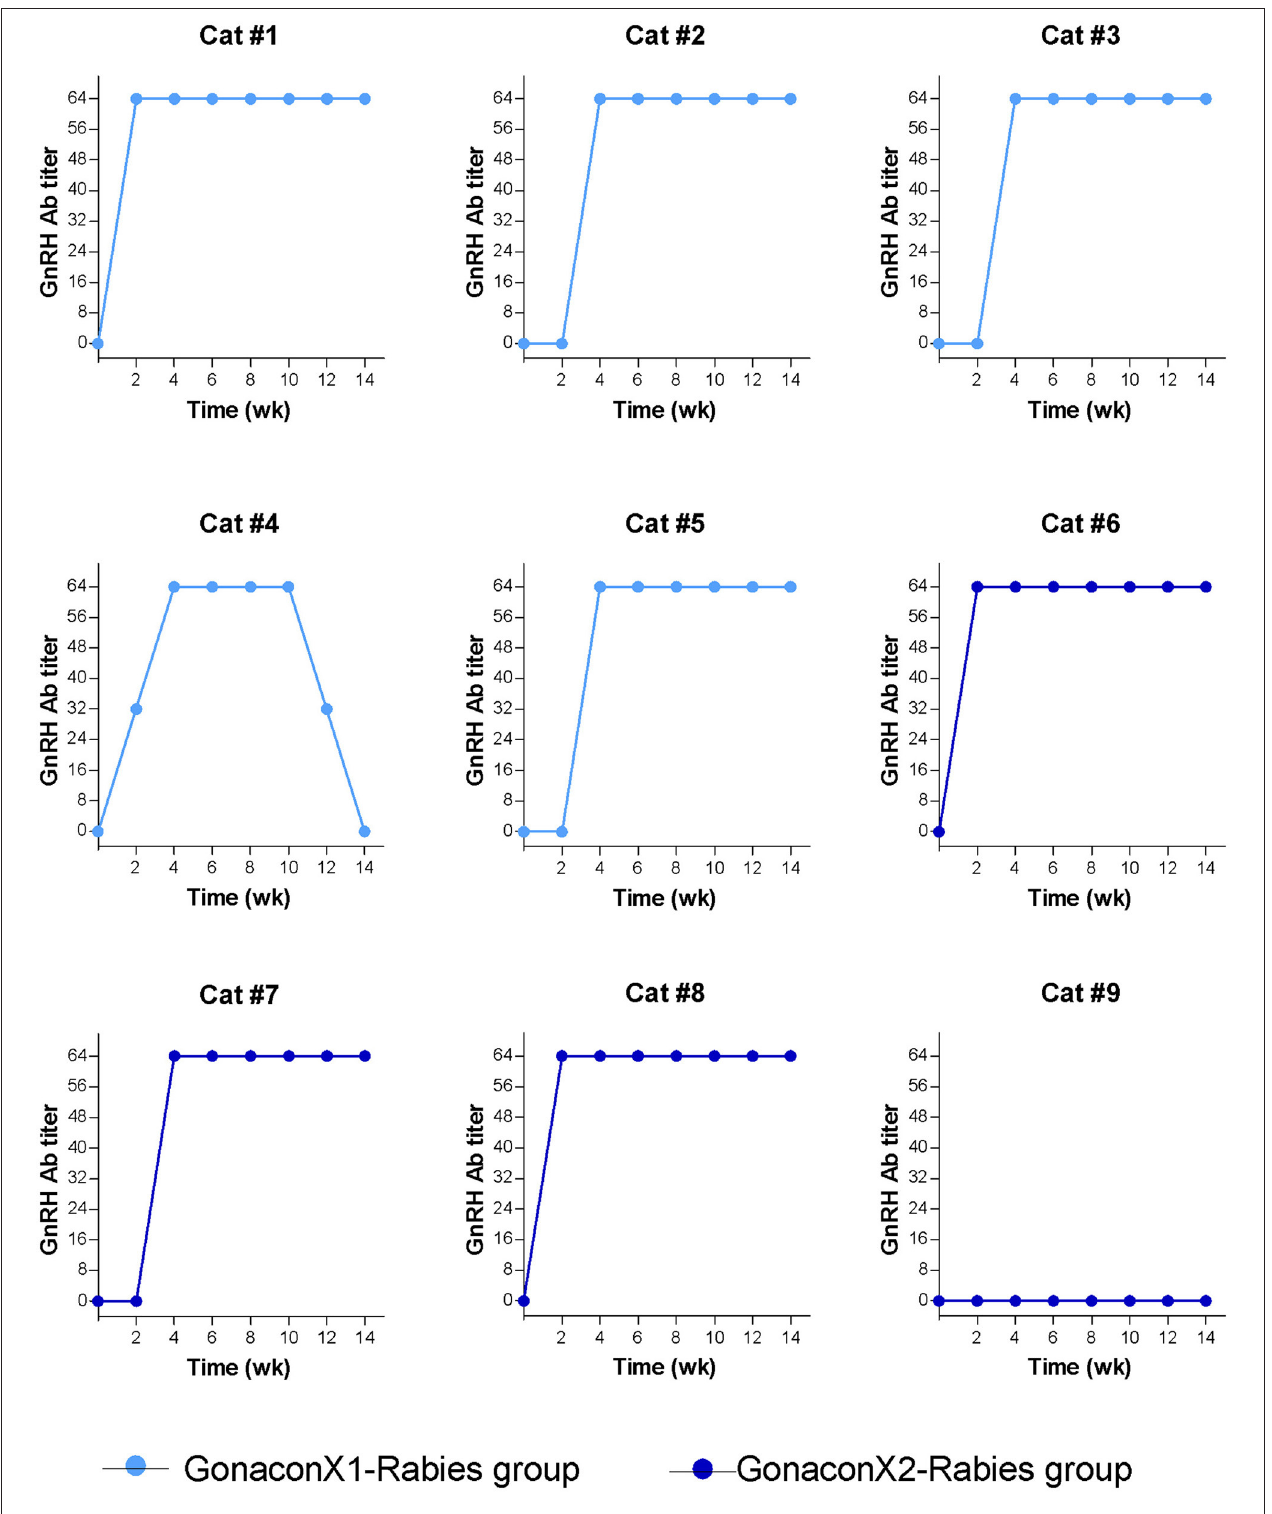
FIGURE 6 | Serum GnRH antibodies titer of individual cats vaccinated with Gonacon. Each graph represents data of a single cat. GonaconX1-Rabies group: cats vaccinated once with both Gonacon and rabies ( n = 5; light blue); GonaconX2-Rabies group: cats vaccinated twice with Gonacon (3 weeks apart) and once with rabies ( n = 4; dark blue); Blood samples were collected every 2 weeks for a total of 14 weeks. Note the reduction of antibodies in cat#4 at weeks 12 and 14, as well as the non-responder cats (#9) in the GonaconX2-Rabies group.